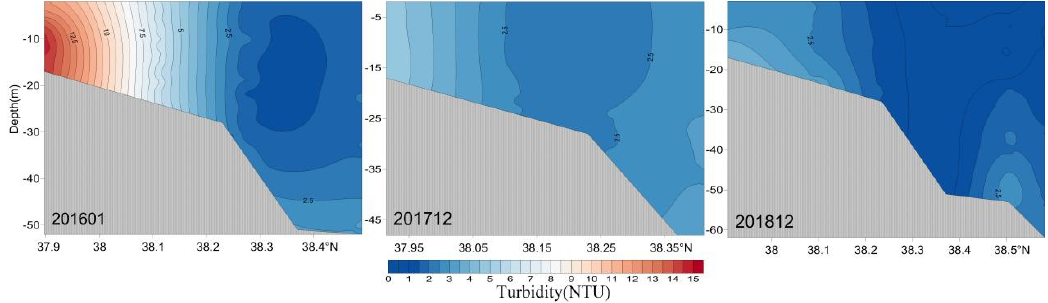
Figure 2. Vertical distribution of measured water turbidity along the transect in the Bohai Strait in winter.